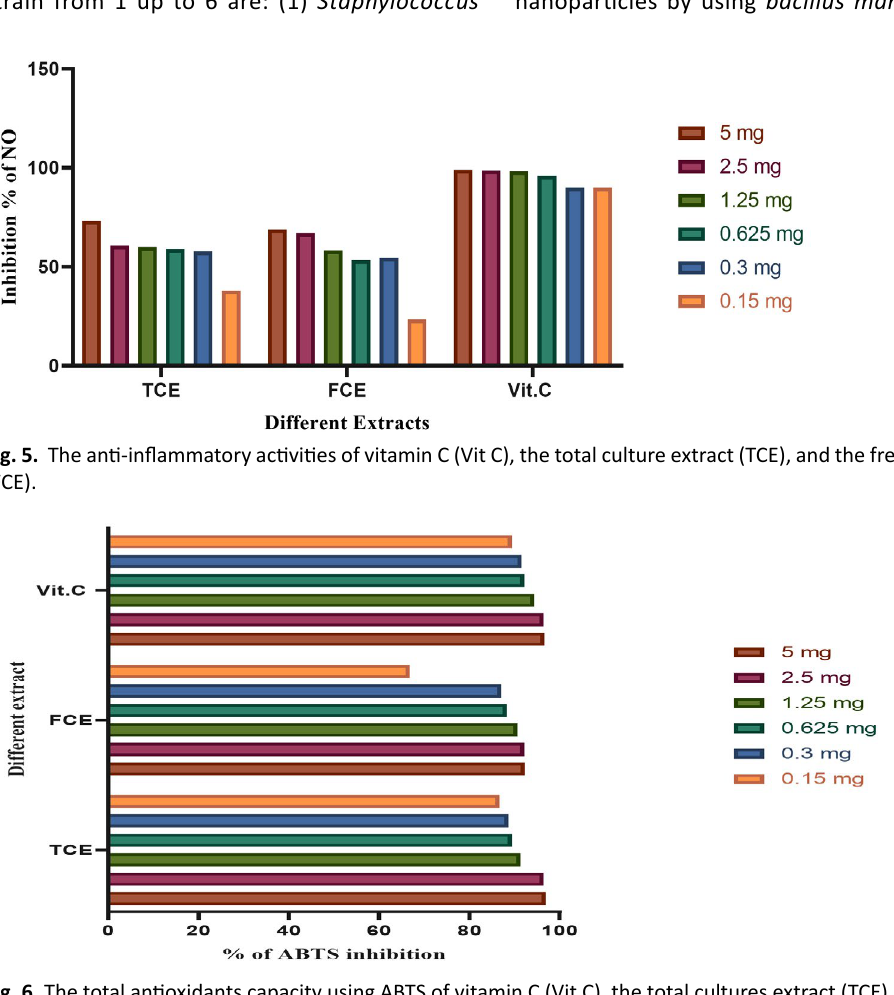
Fig. 6. The total antioxidants capacity using ABTS of vitamin C (Vit C), the total cultures extract (TCE), and the free cell extract (FCE)